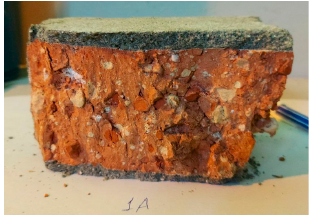
Figure 1. Internal microstructure of the historical brick.